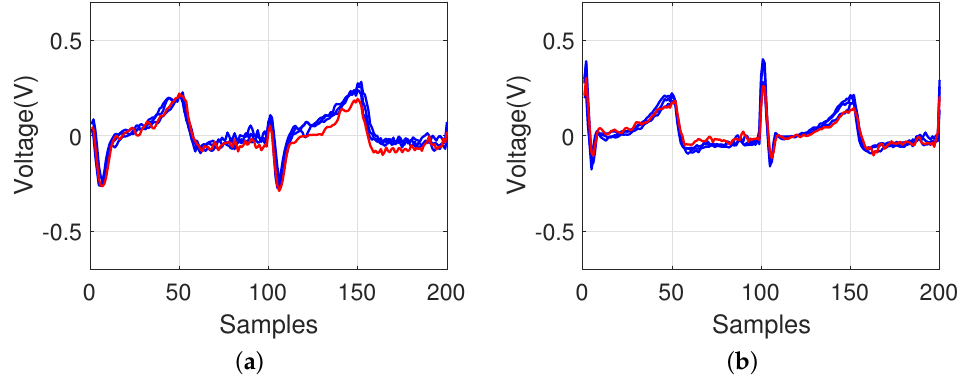
Figure 10. Examples of ECG pattern shown by an overlapping of the unrecognized signals (red-colored line: recognized as a different identity from the same subject). Each subfigure shows the different ECG signals that failed to be